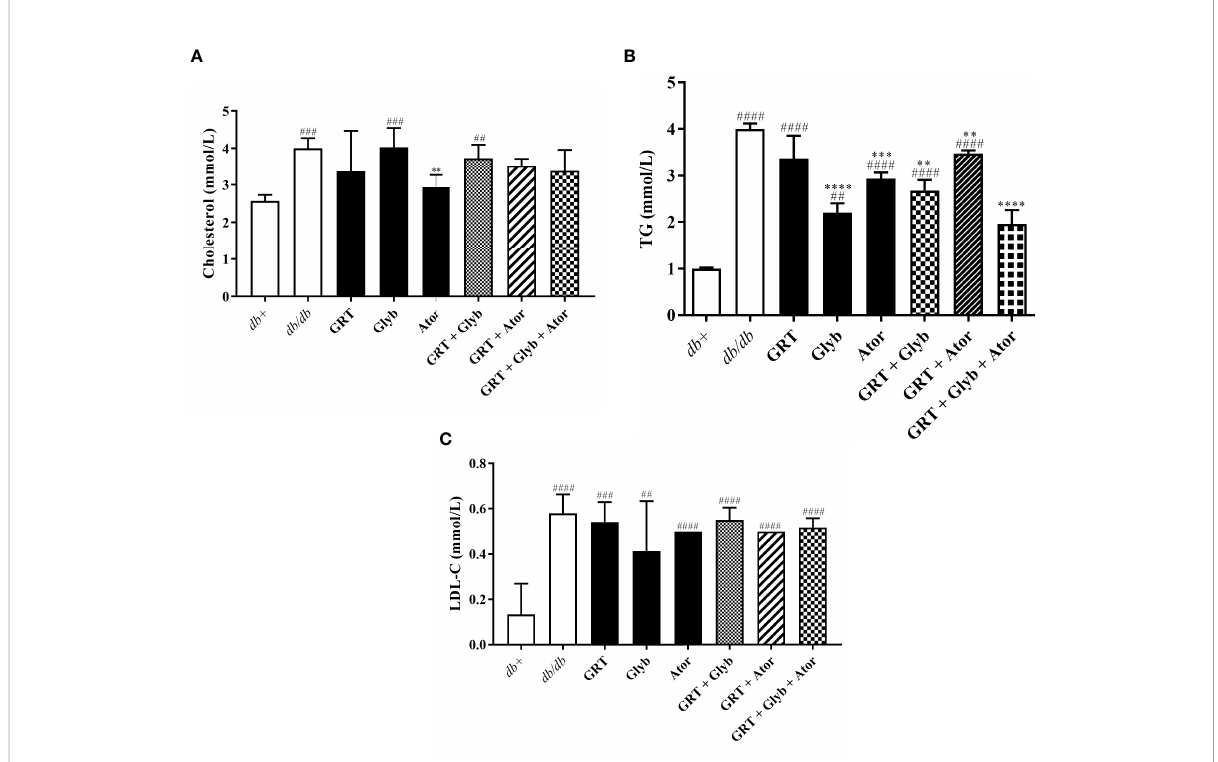
FIGURE 2 The effect of GRT, Glyb, and Ator mono- and combination treatments on serum lipid contents. Serum lipid contents of (A) cholesterol, (B) TG, (C) LDL-C were measured after 5 weeks of treatment. N = 5-6/group. ## p < 0.01, ### p < 0.0001 and #### p < 0.0001 denotes treatment vs db+ (non-diabetic control); **p < 0.01, ***p < 0.0001, and ****p < 0.0001 denotes treatment vs db/db (diabetic control)(One-Way ANOVA followed by Tukey post-hoc test). Abbreviations: TG, triglyceride; LDL-C, low density lipoprotein cholesterol, GRT, green rooibos extract; Glyb, glyburide; and Ator, atorvastatin.